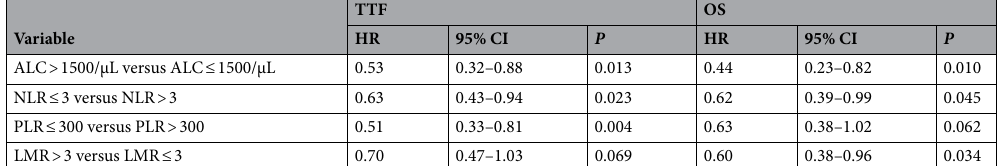
Table 3. Multivariable analysis of time to treatment failure and overall survival (Cox hazard model). ALC absolute lymphocyte count, CI confidence interval, HR hazard ratio, LMR lymphocyte-to-monocyte ratio, NLR neutrophil-to-lymphocyte ratio, OS overall survival, PLR platelet-to-lymphocyte ratio, TTF time to treatment